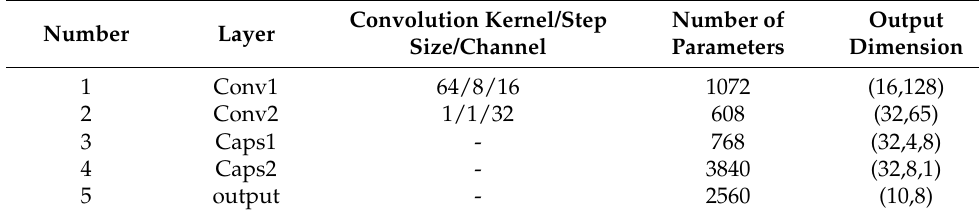
Table 1. Detailed parameters of OT-Caps